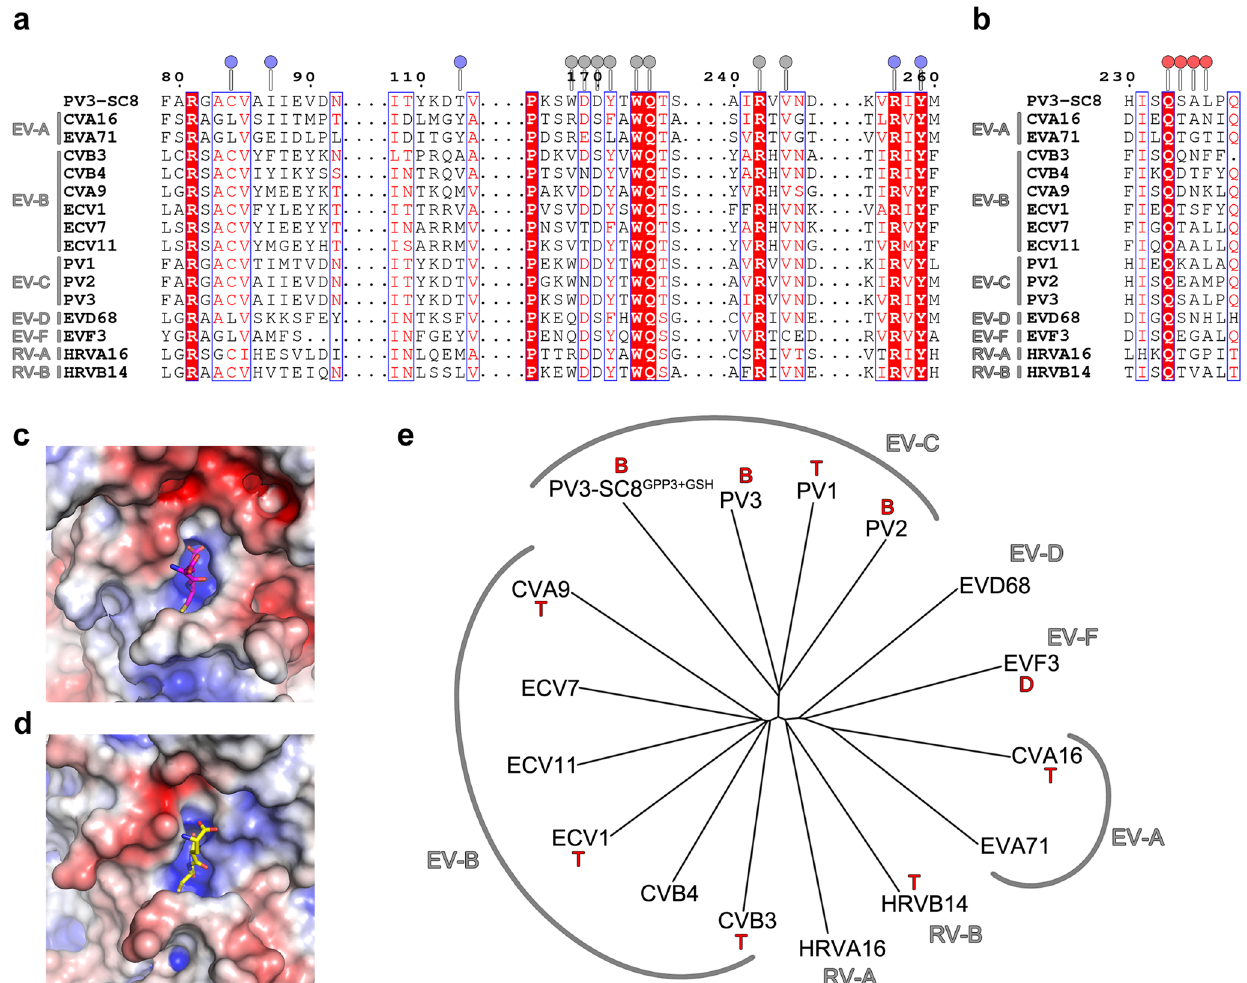
Fig. 3 Conservation of GSH-binding pocket in enteroviruses. a Multiple sequence alignment of the VP1 and b VP3 subunit sequences of PV3-SC8 with several major enteroviruses. Amino acid residues that form the GSH-binding site are marked with circles above the sequence and coloured blue (VP1 protomer A), grey (VP1 protomer B) and red (VP3 protomer A). Enterovirus species A, B, C, D, F and rhinovirus A and B are marked alongside the alignments. c , d Electrostatic charges (±5 kT e − 1 ) mapped onto the molecular surface of c PV3-SC8 GPP3 + GSH and d the EVF3 GSH complex and coloured from blue (positive charge) to red (negative charge). e Phylogenetic tree derived from a structure-based alignment of the representative set of major enteroviruses aligned in a . Those reported to be dependent/stabilised by GSH are marked: T where this was reported in reference 26 , D where reported in reference 30 and B where reported in this paper. Abbreviations for each branch of the tree (PDB ID): CVA16 coxsackievirus A16 (5C4W), EVA71 enterovirus A71 (3VBH), CVB3 coxsackievirus B3 (6ZCL), CVB4 coxsackievirus B4 (6ZCK), CVA9 coxsackievirus A9 (1D4M), ECV1 echovirus 1